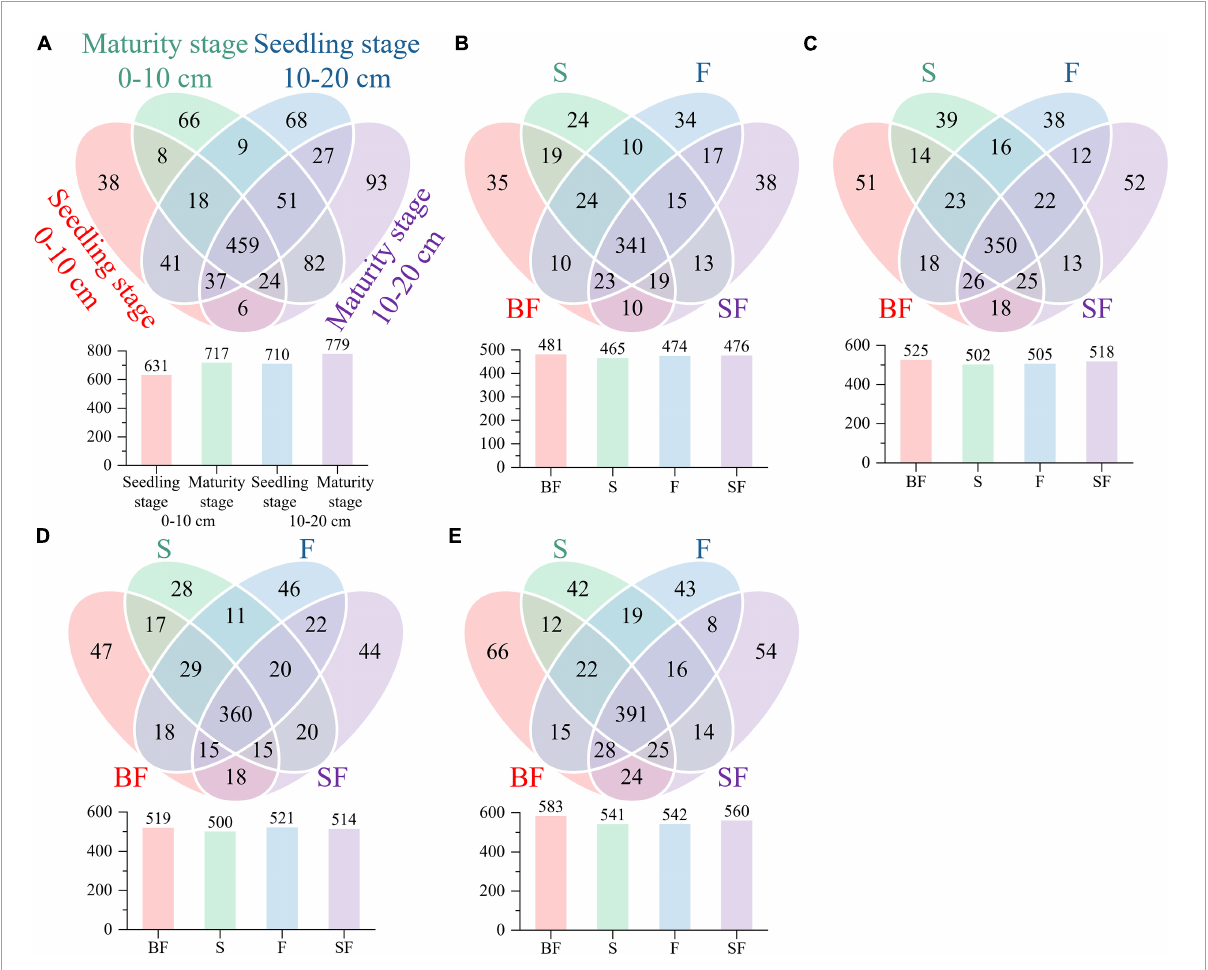
FIGURE3 Comparing bacterial genera using Venn diagrams. (A) growth stages, (B) seedling stage, 0–10 cm, (C) maturity stage, 0–10 cm, (D) seedling stage, 10–20 cm, and (E) maturity stage, 10–20